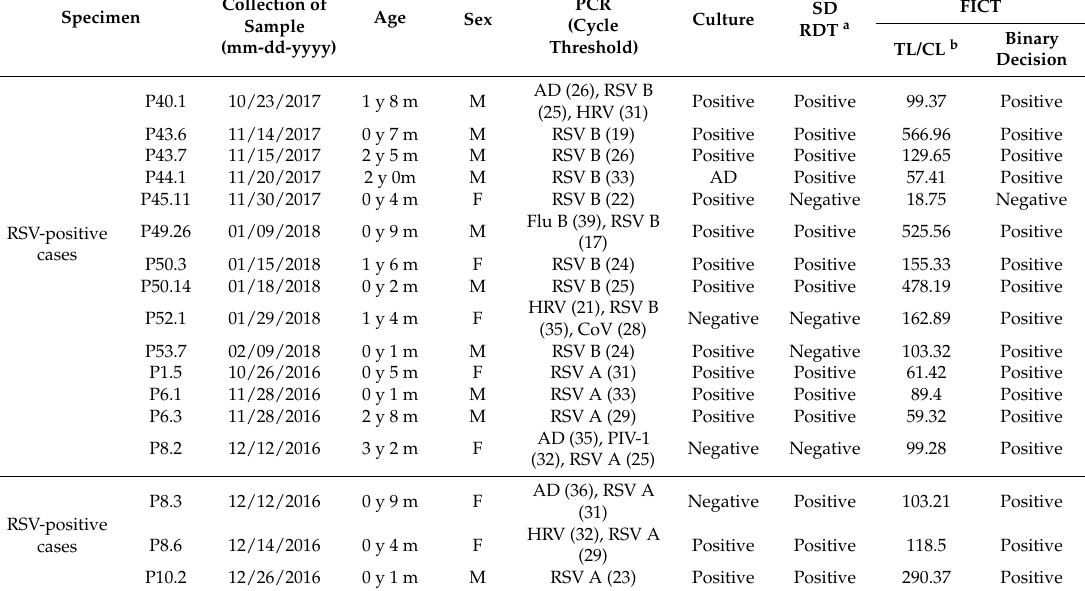
Table 1. Characteristics of clinical specimens.